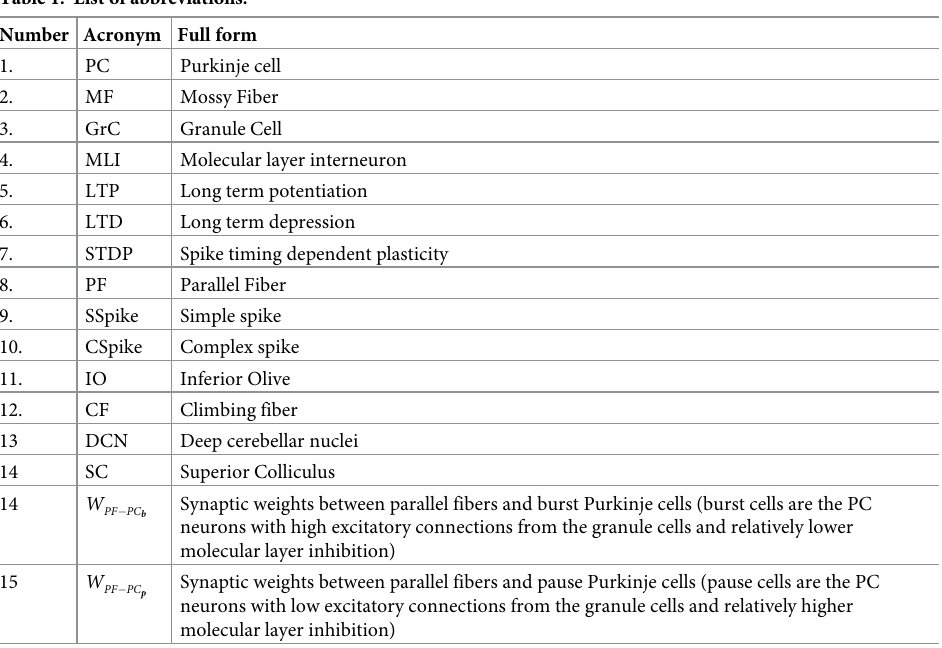
Table 1. List of